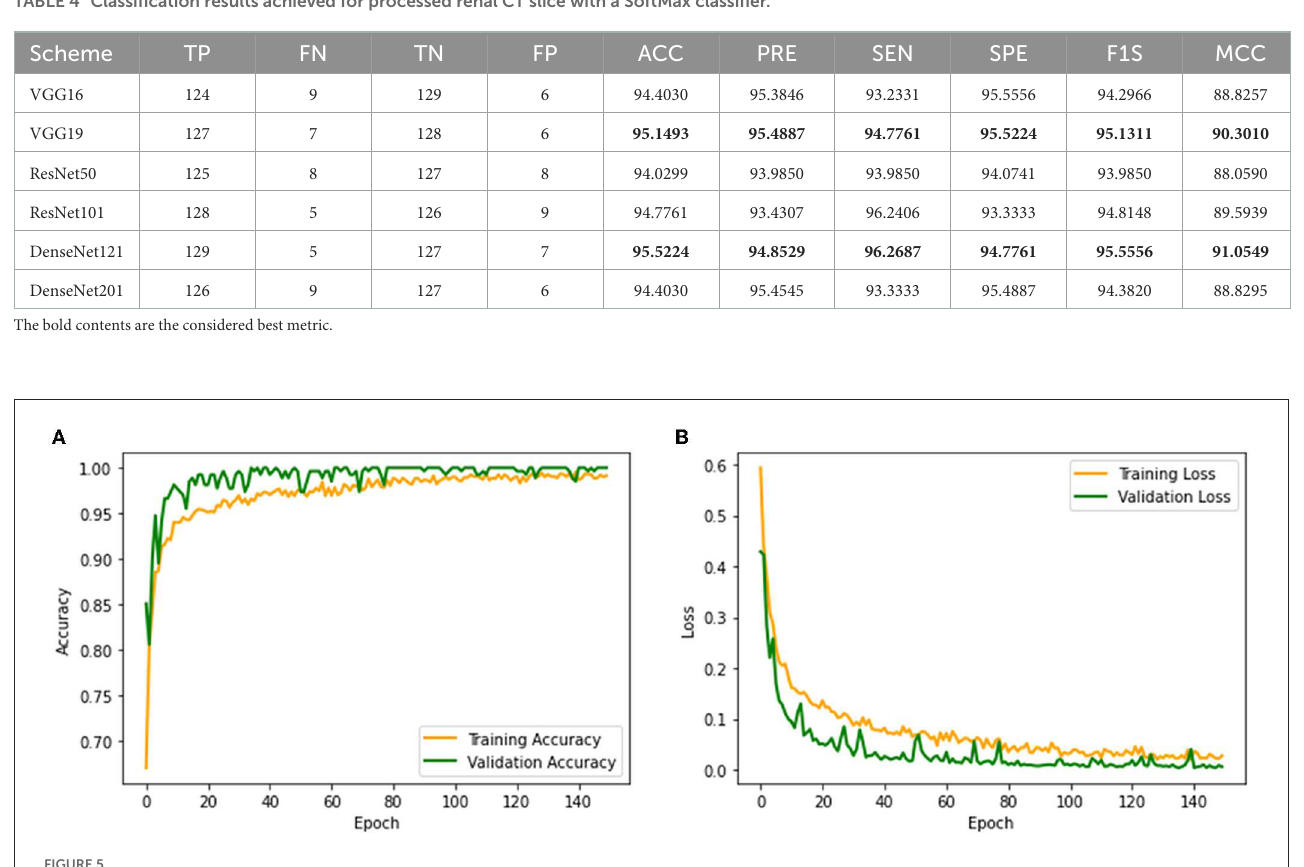
TABLE 4 Classification results achieved for processed renal CT slice with a SoftMax classifier.